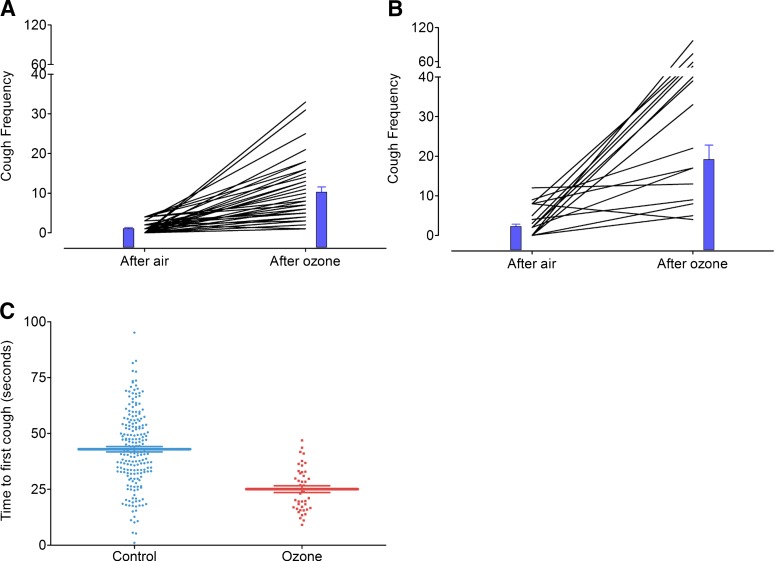
Frequency of cough in response to citric acid (30 mM) (A) and citric acid (100 mM) (B) following exposure to air or ozone (2 ppm, 30-minute exposure) in guinea pigs. The time period between air and ozone exposure was 7 days, and the sequence of whether a guinea pig received ozone or air first was randomized. The blue bars indicate the mean cough response, and the error bars represent the S.E.M. (N = 40 and 16, respectively). (C) Time to first cough in guinea pigs, defined as the time in seconds when the first cough occurred after the nebulizer containing citric acid was turned on. The thick horizontal bar represents the mean and the error bars are the S.E.M., N of 198 for the guinea pig controls and 48 for the ozone-sensitized guinea pigs.